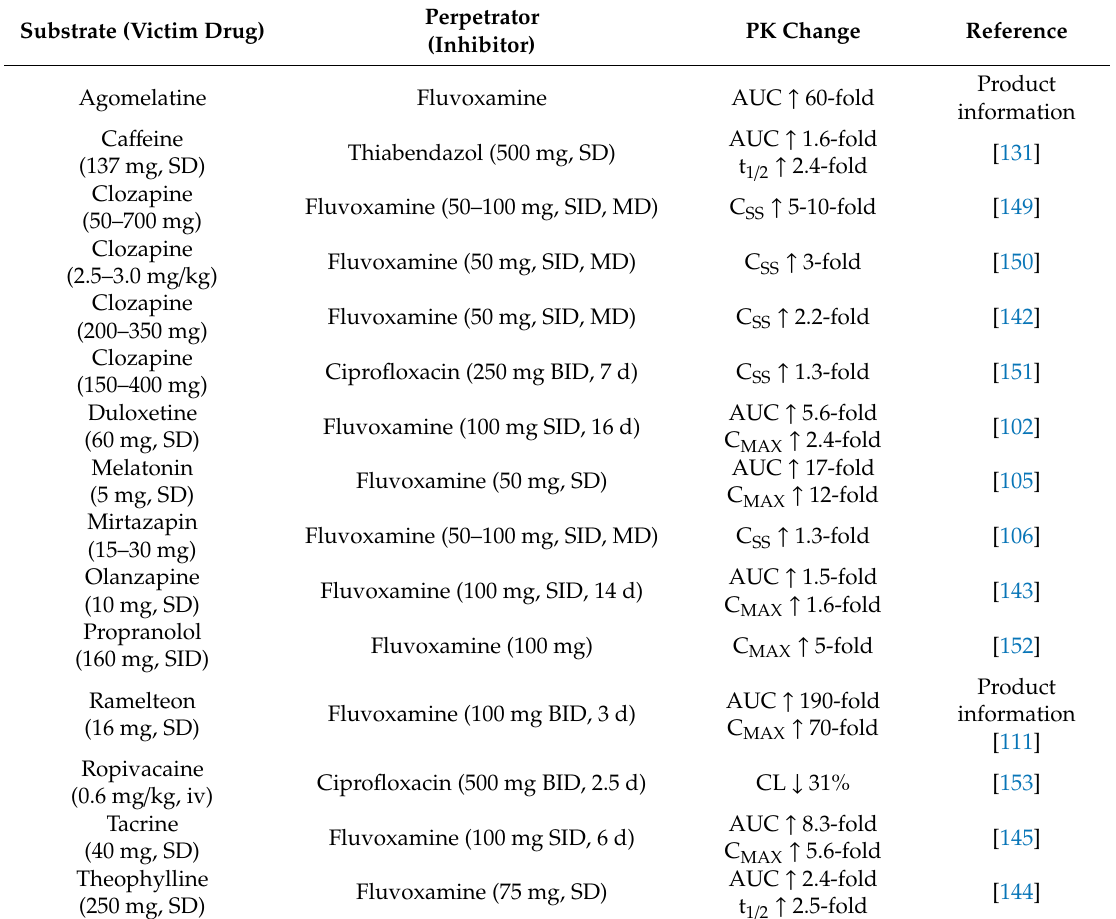
Table 5. Overview of clinically relevant interaction as caused by inhibition of CYP1A1 / 1A2 enzymes. Substrate (Victim